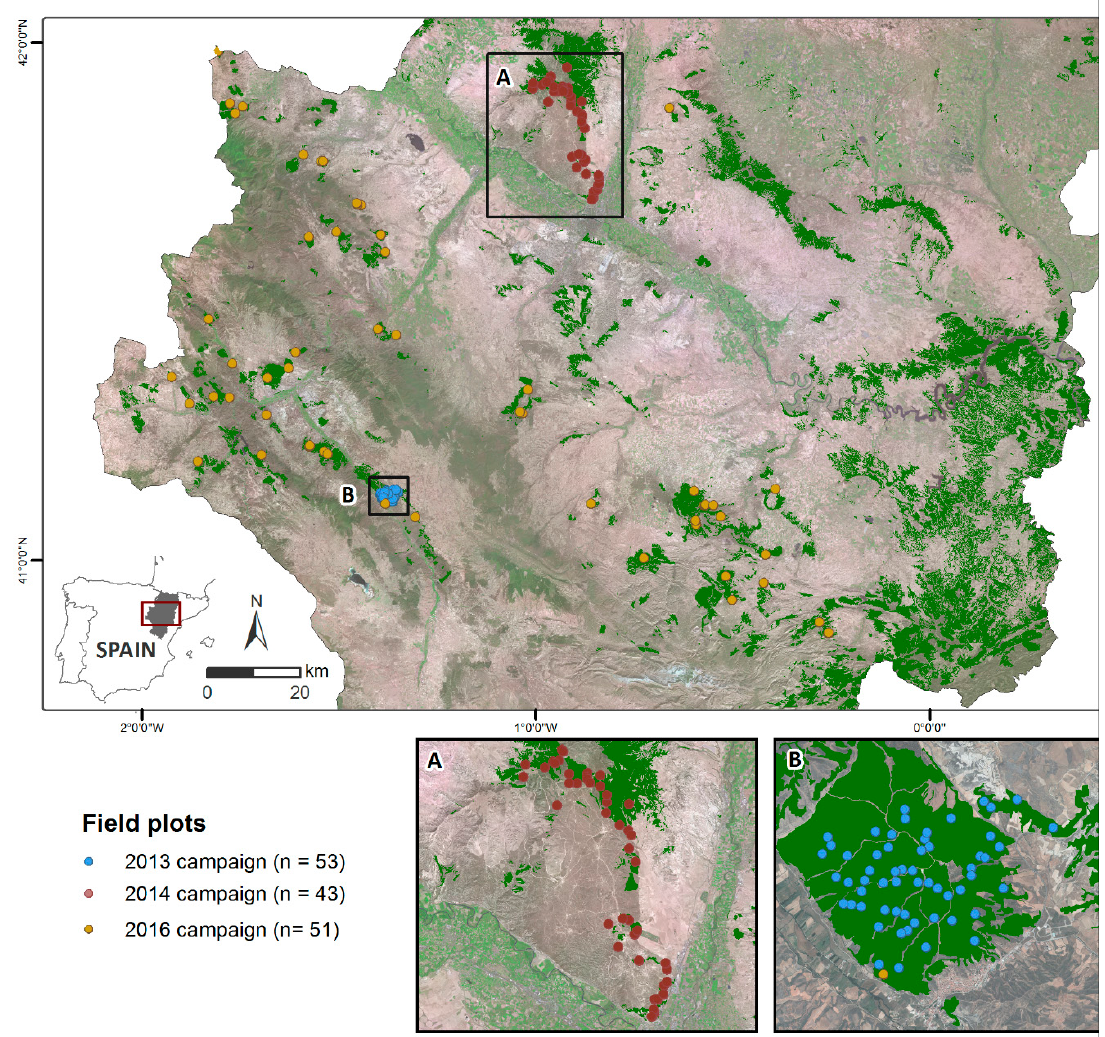
Figure 1. Study area with the location of forest inventory plots. High spatial resolution orthophotography from Spanish National Plan for Aerial Orthophotography spatial data infrastructure (SDI) service [54] is used as a backdrop.